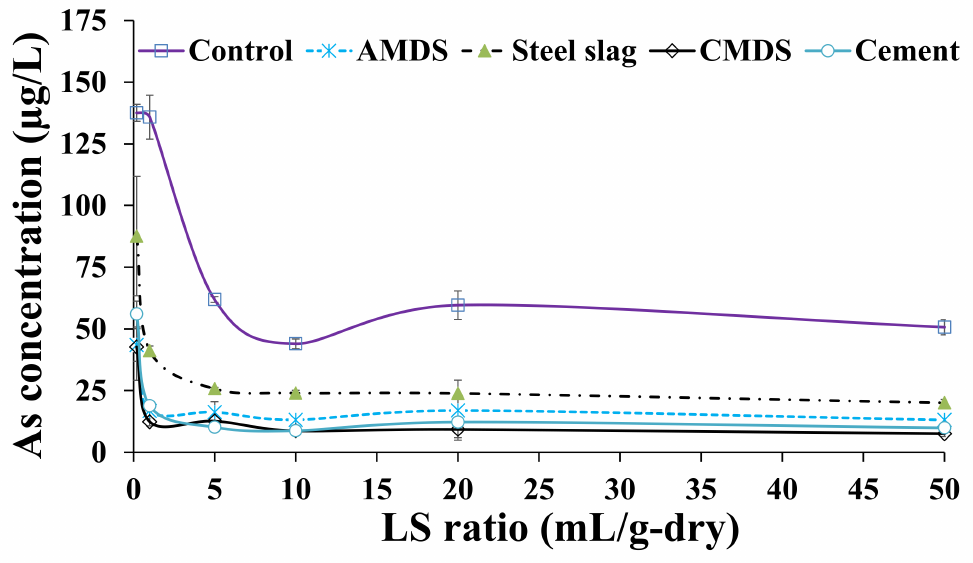
Figure 5. Eluate concentration curves of the released arsenic from contaminated (control) and stabilized soils as a function of L/S ratio using the column-percolation